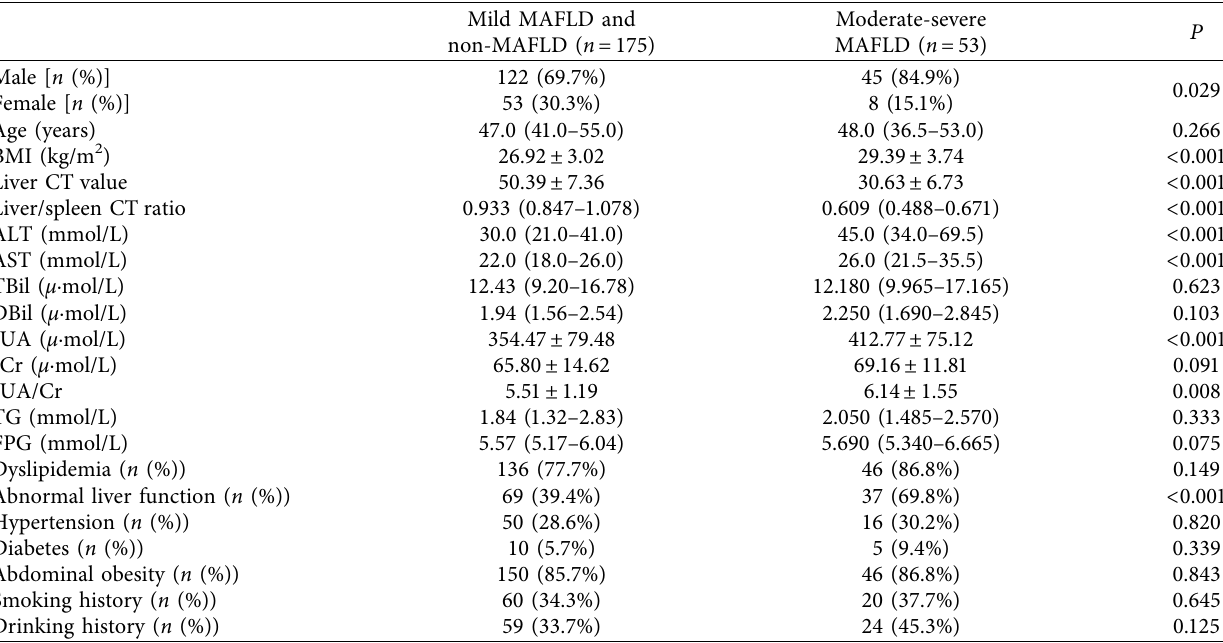
Table 1: Characteristics of study participants ( n �